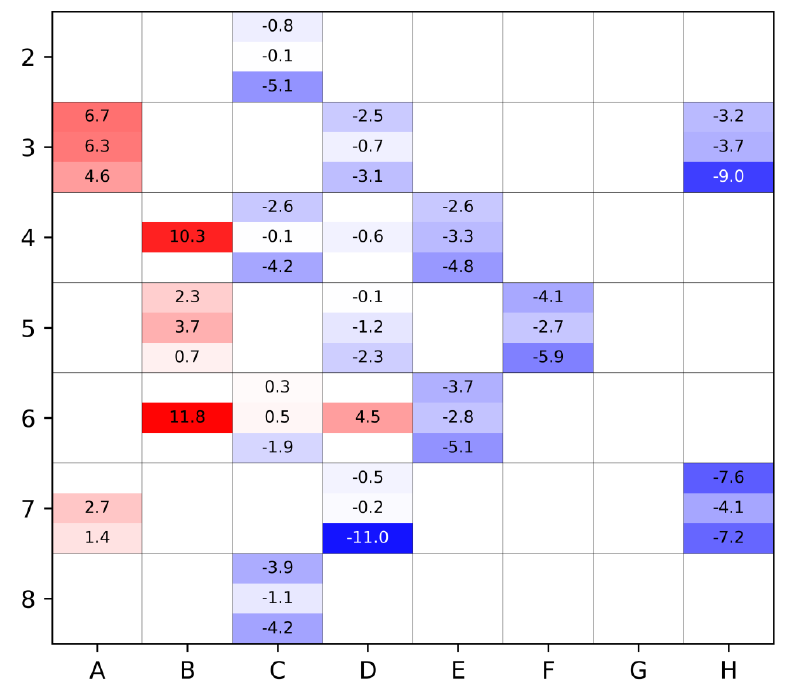
Figure 6. Relative differences in the calculated and experimental Cu-63 reaction rates for cycle 2017-07 (C/E-1, in %). Results are integrated between ±28 cm with respect to core center line.